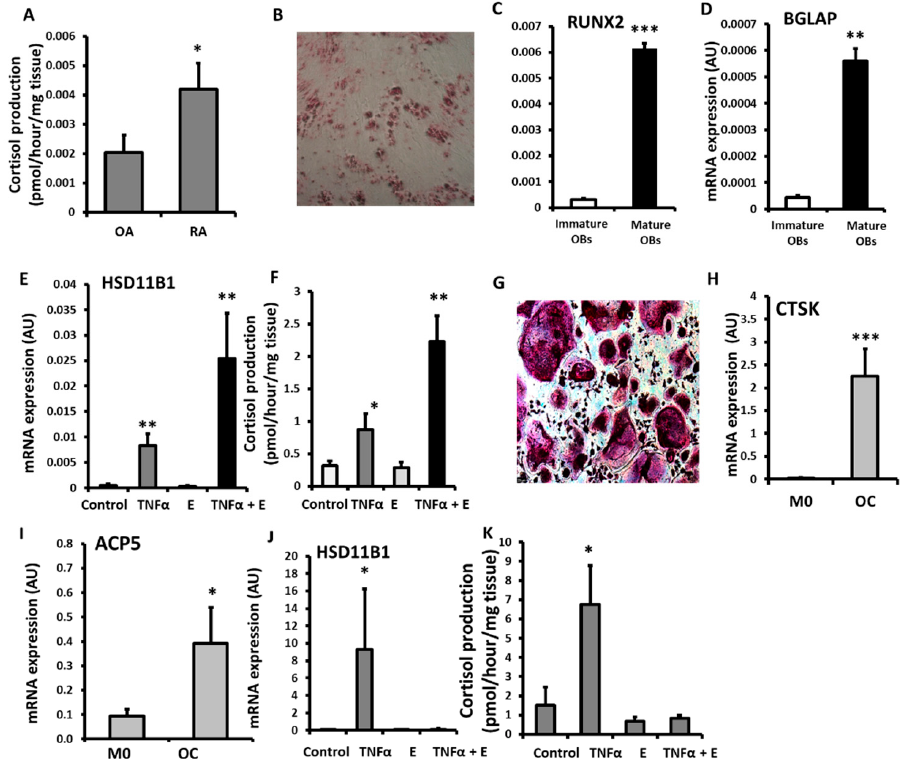
Figure 1. ( A ) Glucocorticoid activation by 11 β HSD1 in ex vivo tibia explants freshly isolated after joint replacement surgery from patients with rheumatoid arthritis (RA, n = 8) and osteoarthritis (OA n = 9) determined by scanning thin-layer chromatography. ( B ) Alizarin red staining of osteoid nodules in primary human osteoblast (OBs) culture isolated from OA tibia. ( C ) RUNX2, ( D ) BGLAP and ( E ) HSD11B1 mRNA expression (AU) determined by RT qPCR and ( F ) glucocorticoid activation by 11 β HSD1 in primary human osteoblast cultures isolated from OA tibia following treatments with either TNF α (10 ng/mL), cortisone (denoted E) (1000 nmol/L) or a combination of both for 24 h. ( G ), TRAP staining of multinucleated primary human osteoclast (OC) culture isolated from peripheral blood mononuclear cells. ( H ) CTSK and ( I ) ACP5 mRNA expression (AU) determined by RT qPCR in primary human macrophages (M0) and osteoclasts (OC) cultures isolated from peripheral blood mononuclear cells. ( J ) HSD11B1 expression (AU) determined by RT qPCR, and ( K ) glucocorticoid activation by 11 β HSD1 in primary human osteoclast culture isolated from peripheral blood mononuclear cells following treatments with either TNFa (10 ng/mL), cortisone (1000 nmol/L) or a combination of both for 24 h. Values are expressed as mean ± standard error, n = 4 per group for primary culture. Statistical significance was determined using either two-way or one-way ANOVA with Tukey post hoc analysis. * p < 0.05, ** p < 0.01 and *** p <